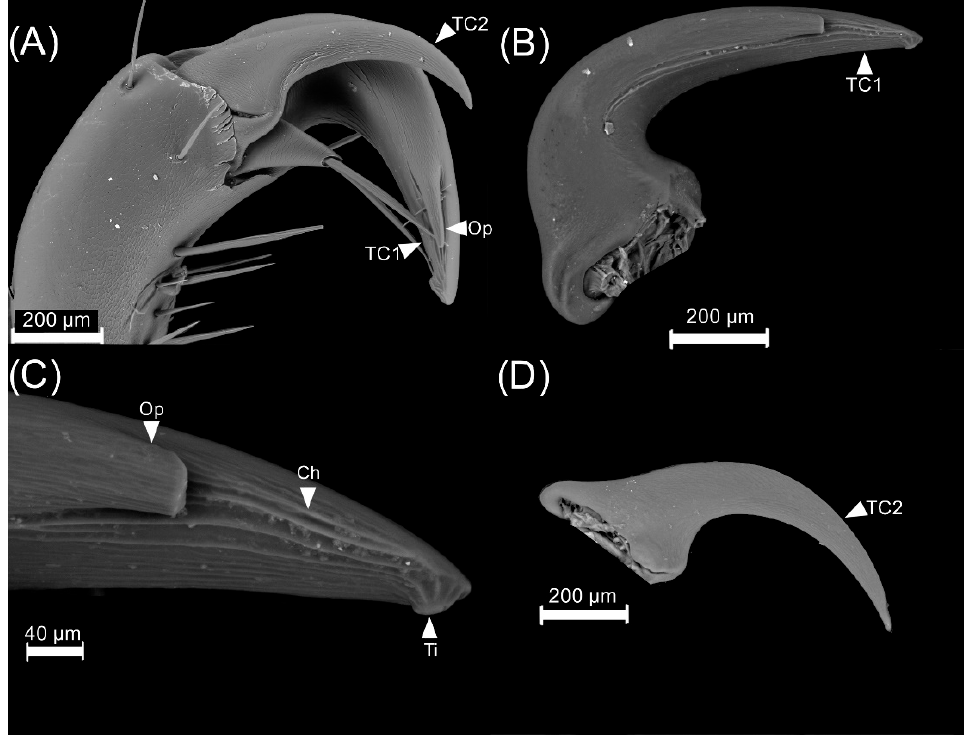
Figure 12. Tarsal claw of the first pair of legs of Cyclocephala barrerai males: ( A ) general view of the tarsal claw composition, ( B ) tarsal claw 1, ( C ) close-up of tarsal claw 1, ( D ) tarsal claw 2. TC1 = tarsal claw 1, TC2 = tarsal claw 2, Op = opening, Ch = channel, Ti = tip.